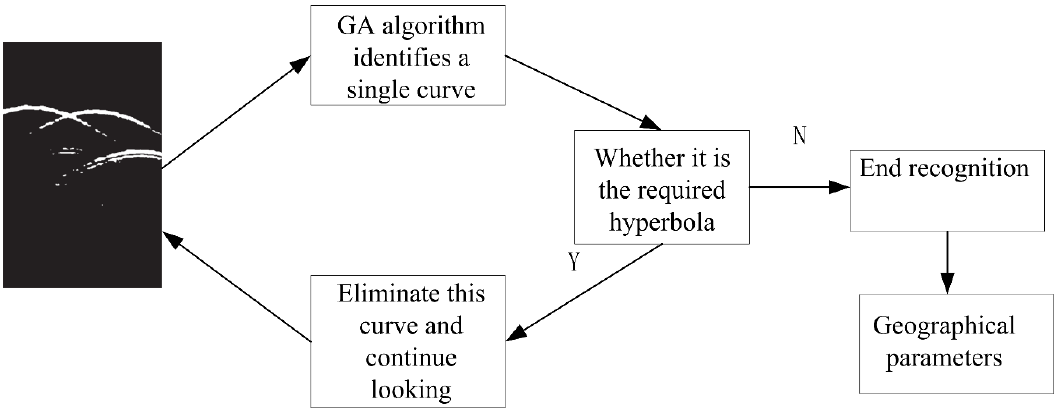
Table 2. Genetic algorithm performances at the scenarios level.